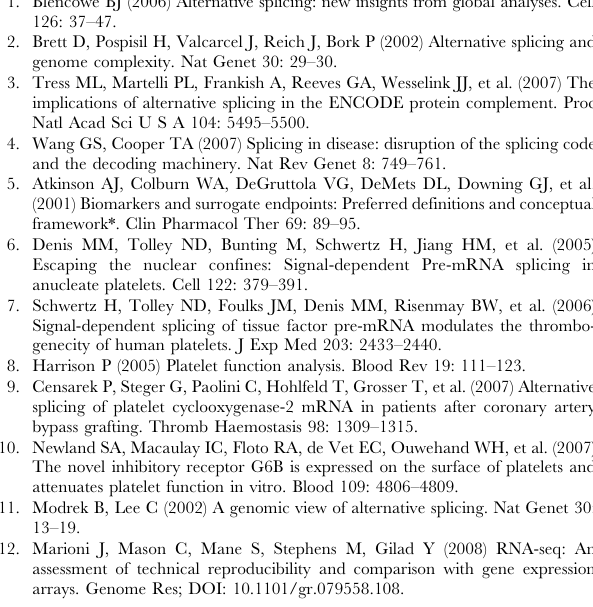
Table S2 Numbers of platelet peptide and protein identifications in IPI and SkipE databases